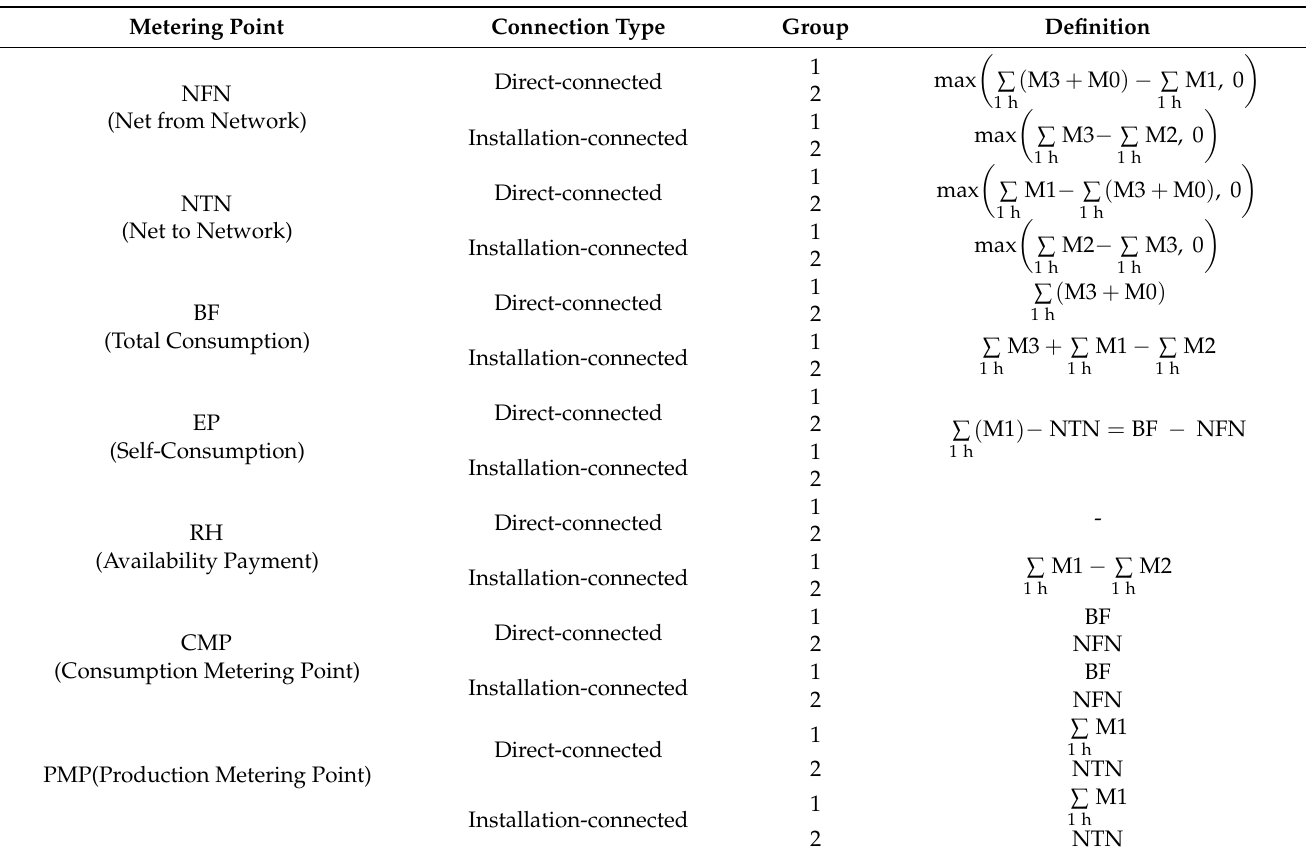
Table 2. Defined metering points for net settled facilities.